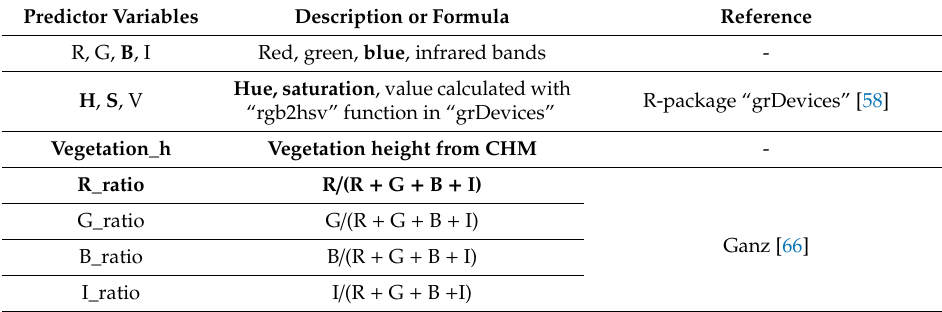
Table 2. List of ratios tested as predictor variables for the random forest (RF) model. Variables selected in the final model are displayed in bold.